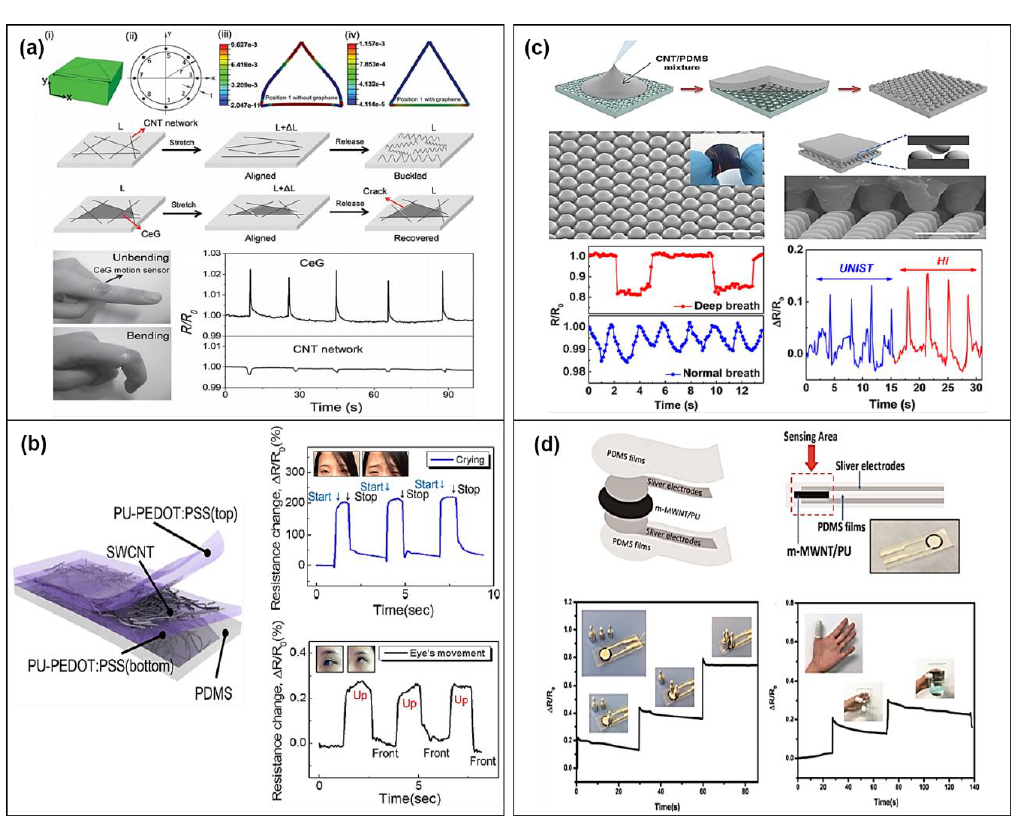
Figure 4. Illustration and characterizations of CNT-based strain and pressure sensors. ( a ) Strain sensors with graphene reinforced in the CNT network and stretchable wearable applications in finger motion detection (reproduced with permission [79] copyright 2016, Wiley-VCH). ( b ) Structure of the strain sensor consisting of the three-layer stacked nanohybrid structure of PU-PEDOT:PSS / single-walled carbon nanotube (SWCNT) / PU-PEDOT:PSS on a PDMS substrate and the responses of the sensor for subtle changes such as emotional expressions and eye movements (reproduced with permission [34] copyright 2015, American Chemical Society). ( c ) Schematic showing fabrication and structure of a microdome-shaped CNT-PDMS composite / sensor and the applications in detection of human breathing flows and voice vibrations (reproduced with permission [84] copyright 2014, American Chemical Society). ( d ) Photograph of the highly stable and flexible pressure sensor and relative change of resistance for static loading pressures and subject’s finger gestures (reproduced with permission [35] copyright 2018, MDPI